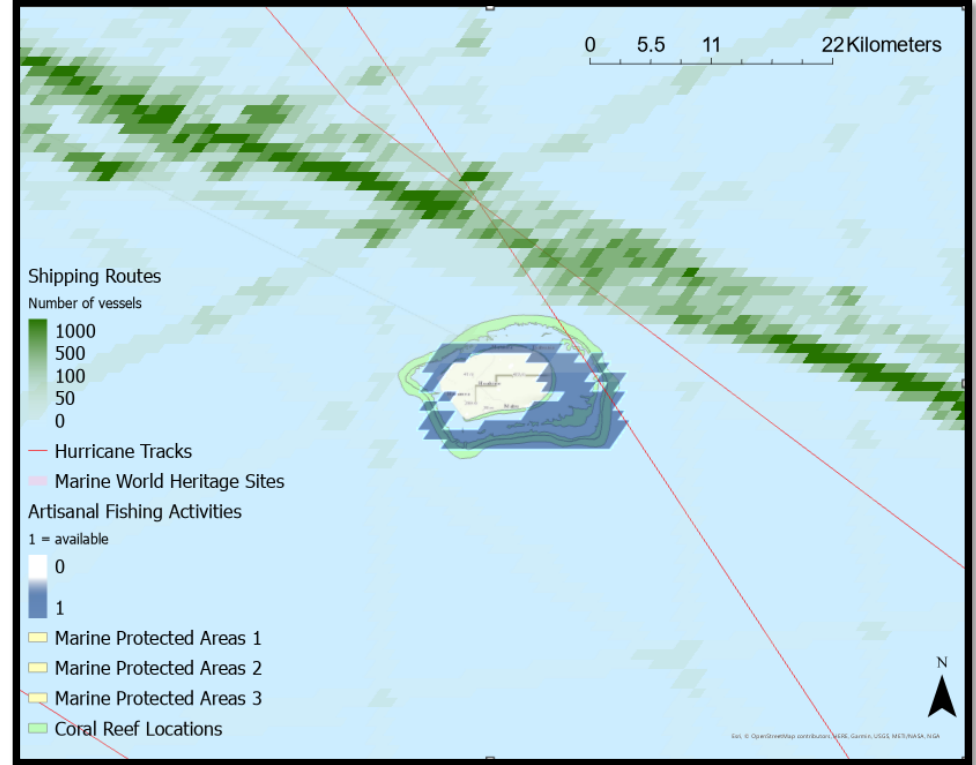
Figure 4. Map for Tubuai demonstrating challenges found through spatial analysis. The shipping routes are shown using a green color scale to represent the number of vessels that traveled through this area for one year (each raster has a 920 m 2 area). Artisanal fishing activities are present in the blue shaded areas. The remaining layers are colored separately, red for hurricane tracks, yellow for marine protected areas, light green for coral reefs, and pink for marine world heritage sites.